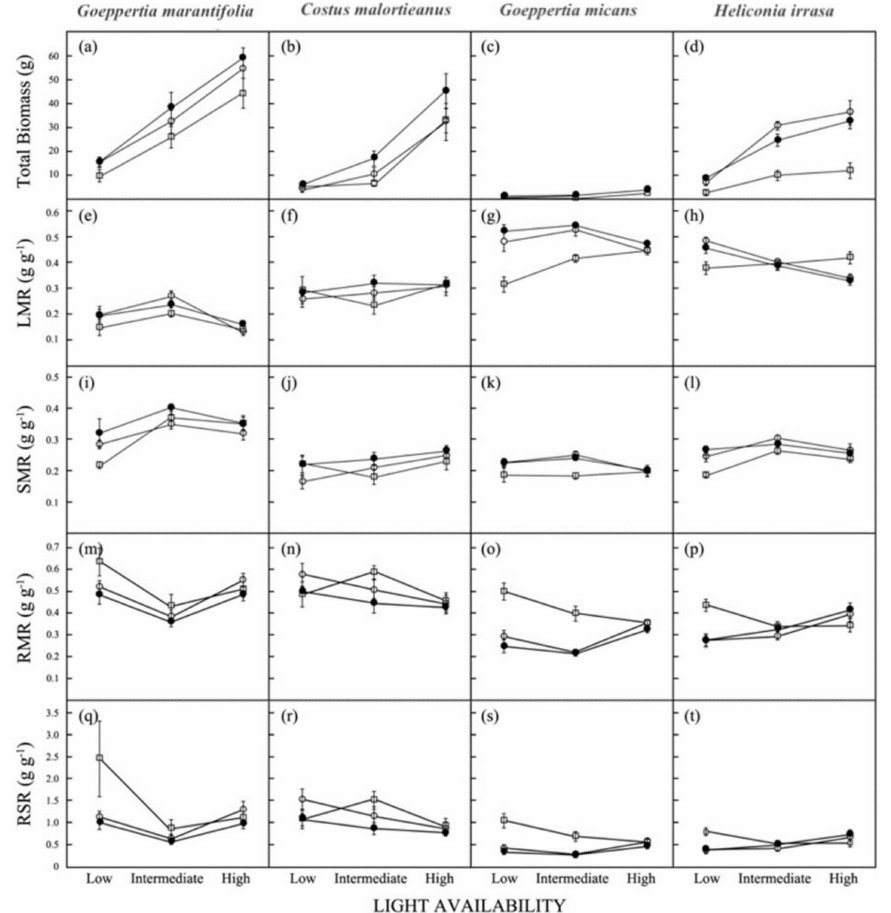
Figure 4. Effects of light availability (low, intermediate, and high) and defoliation (closed circle = control, open circle = 50%, and open square = 100% leaf removal) on biomass allocation parameters for four understory herb species: total biomass ( a – d ), leaf mass ratio (LMR, ( e – h )), stem mass ratio (SMR, ( i – l )), root mass ratio (RMR, ( m – p )), and root-to-shoot ratio (RSR, ( q – t )). Values are mean ± 1